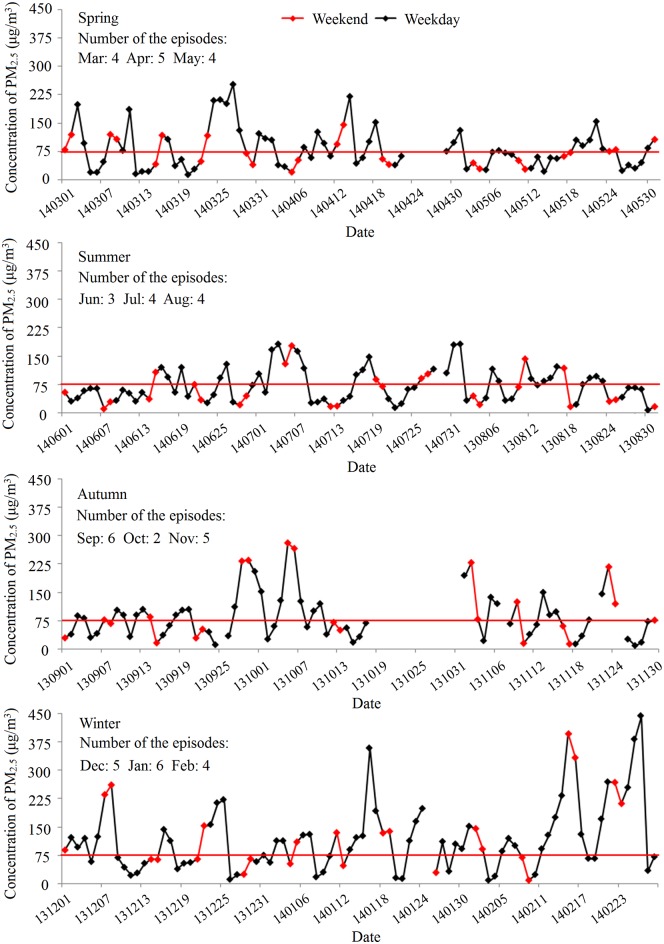
Day to day variations of PM2.5 in different seasons, Beijing, 2013–2014.